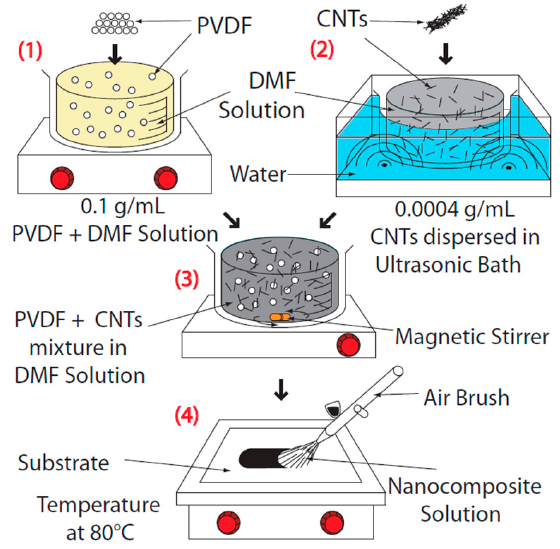
Figure 1. The schematic of the fabrication process.